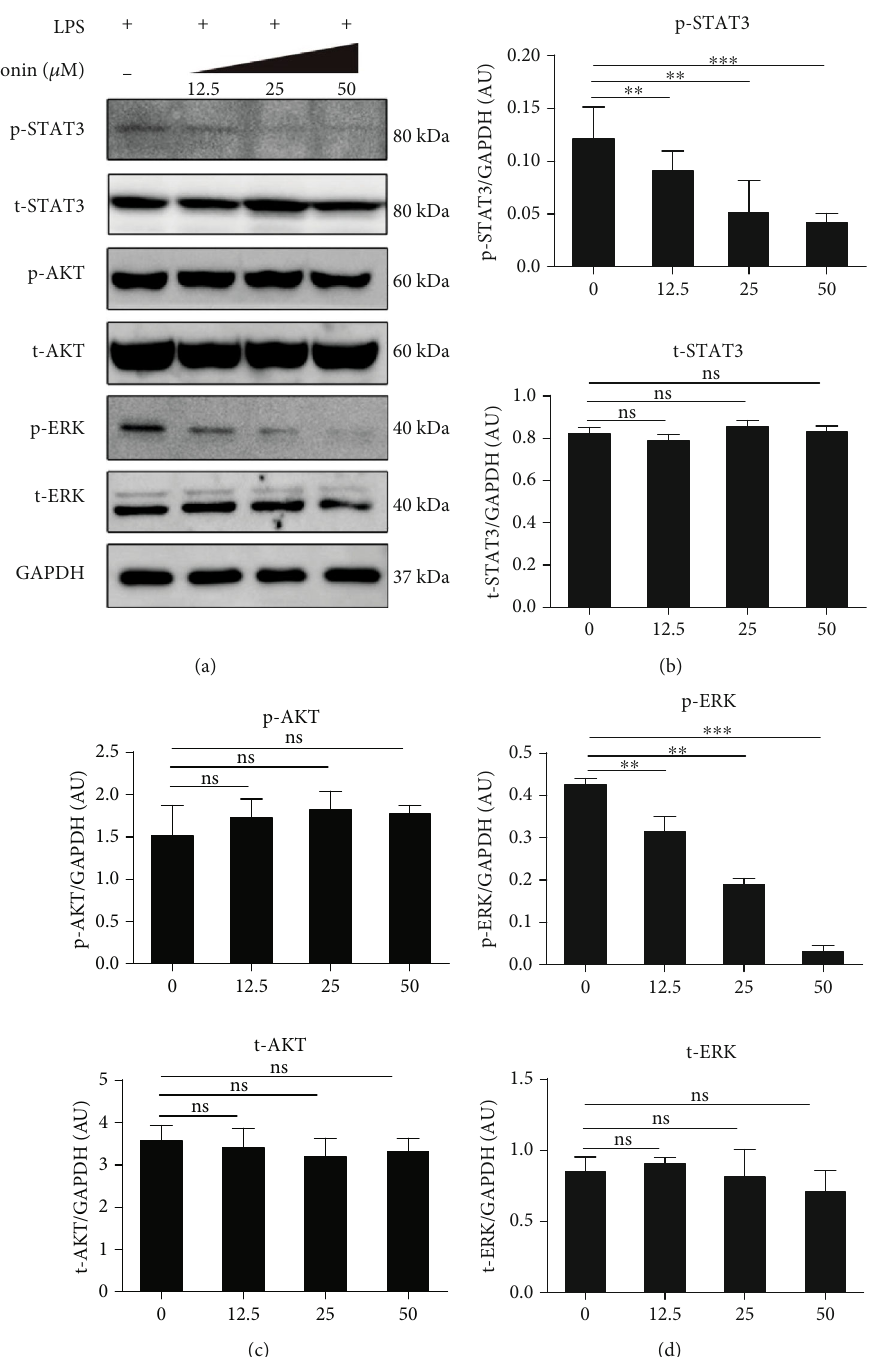
Figure 5: Dose-dependent inhibition of STAT3 and ERK phosphorylation by Wogonin in LPS-treated B cells. CD19 + B cells were cultured with LPS for 6 h in the presence or absence of Wogonin (12.5, 25, and 50 μ M). (a – d) The total and phosphorylated protein levels of STAT3, AKT, and ERK in LPS-treated B cells under di ff erent concentrations of Wogonin were analyzed and quanti fi ed by western blot. Data are representative of fi ve independent experiments. GAPDH was used as loading controls. ∗∗ P < 0 : 01 ; ∗∗∗ P < 0 : 001 ; ns: no signi fi